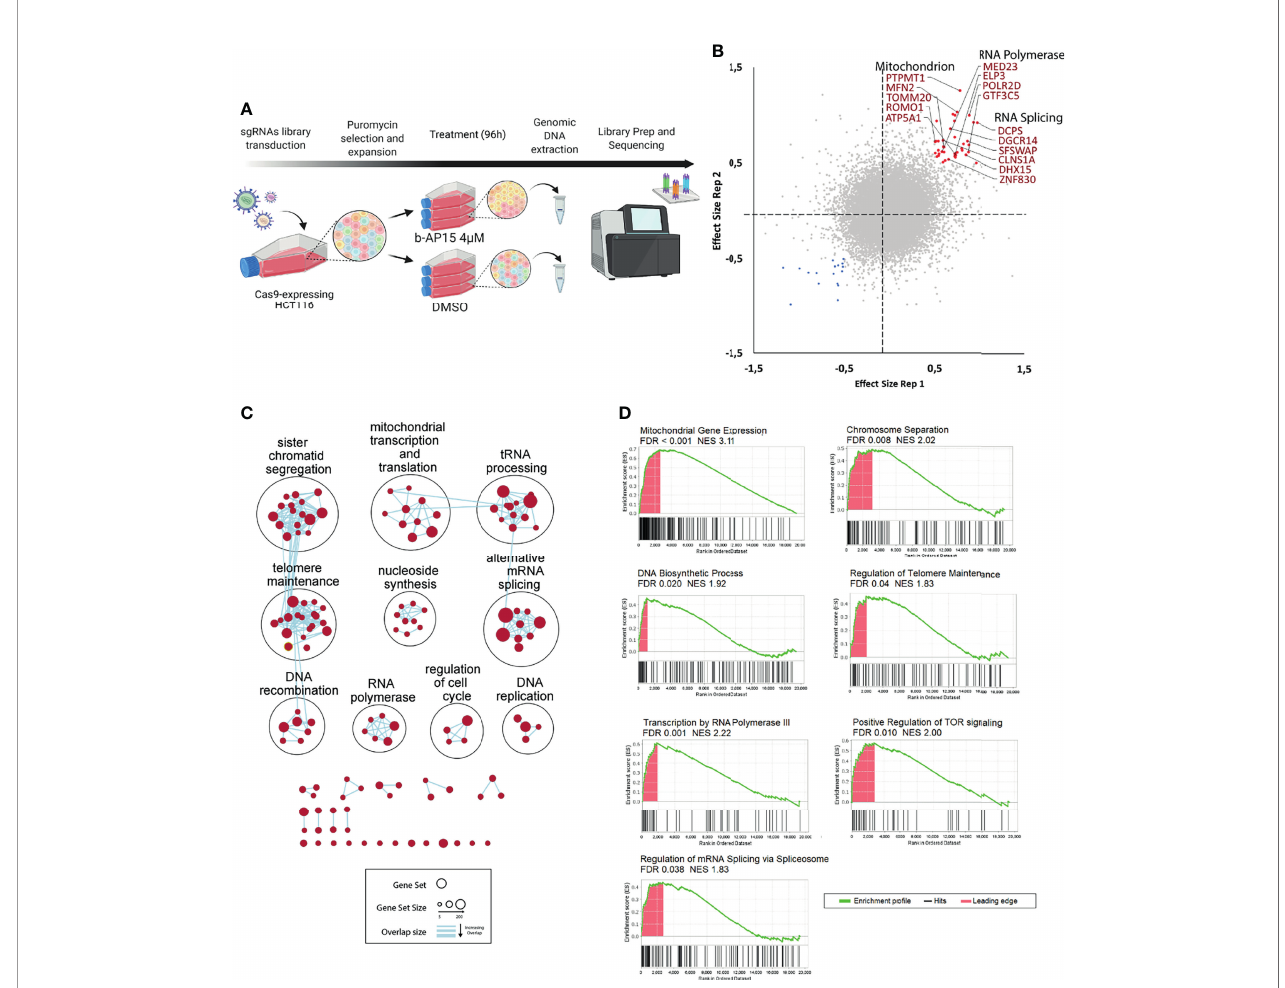
FIGURE 8 | CRISPR-Cas9 loss-of-function screening. (A) Schematic representation of the strategy for the CRISPR dropout screen. Cas9-expressing HCT116 cells were transduced with an sgRNA library targeting 19,364 protein-coding genes. Transduced cells were selected using puromycin. The cells are then expanded, split into two groups and treated with either b-AP15 or DMSO for 96 hours. After the treatment, genomic DNA is extracted and sequenced. (B) Correlation plot for two replicates. Red points represent guides that were enriched (>0.5 effect size) and blue points are the guides that were depleted (<-0.5 effect size) in the b-AP15- treated vs control cells in duplicate samples. Effect size is the log 2 of the ratio of normalized read counts for the sgRNA in the b-AP15-treated vs control cells. Guides present in enriched gene sets (mitochondrial genes, RNA polymerase components, and genes involved in RNA splicing) are labeled. (C) Network analysis of enriched gene sets. Gene set enrichment analysis was done on the sgRNAs ranked from the most enriched (targeting genes that confer sensitivity) to the most depleted (targeting genes that confer resistance). All gene sets with FDR < 0.1 were clustered based on their degree of overlap or similarity in genes. No gene sets were signi fi cantly overrepresented for depleted sgRNAs. (D) Enrichment of representative gene sets from the identi fi ed gene set clusters. The bar below the enrichment plot show the order of genes belonging to the gene set (hits) in the list of sgRNAs ranked from the most enriched (left) to the most depleted (right). Leading edge are the hits that contribute most to the gene set enrichment